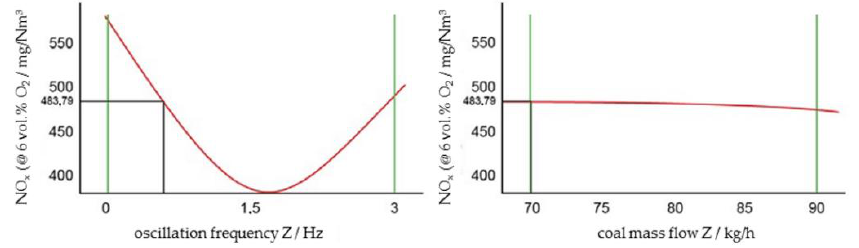
Figure 10. Determination of the optimum frequency of the oscillation with respect to NO x .